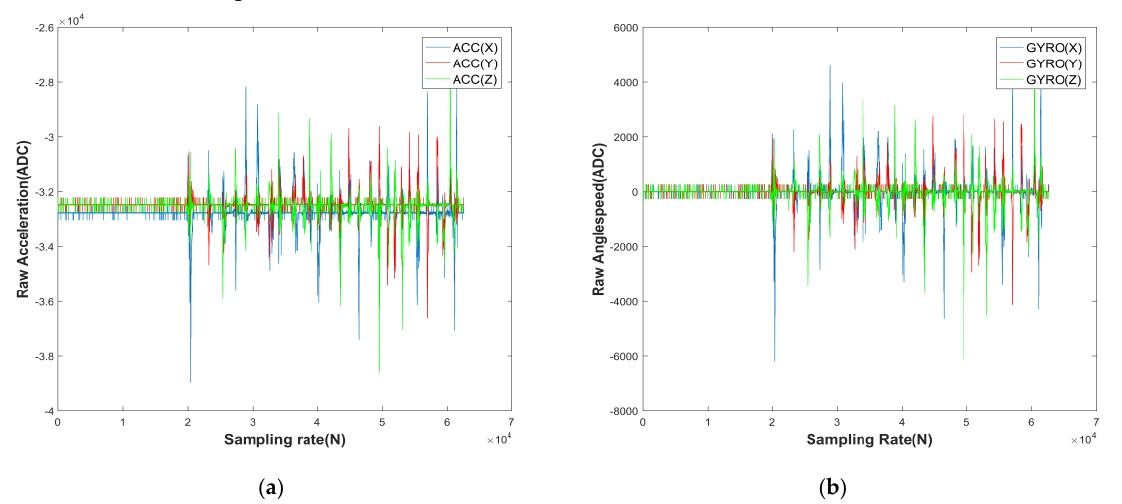
; Figure 4 below reflects the static and dynamic distribution of the entire sensor pose transition.